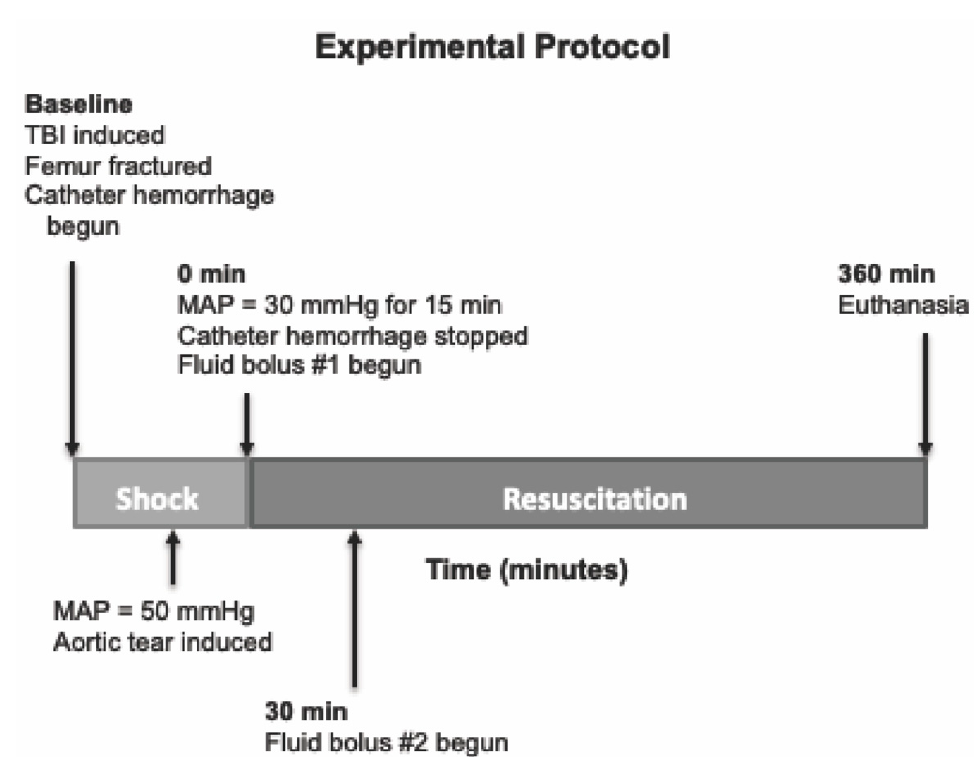
Figure 1. Overview of experimental protocol timeline. TBI, traumatic brain injury. MAP, mean arterial pressure.